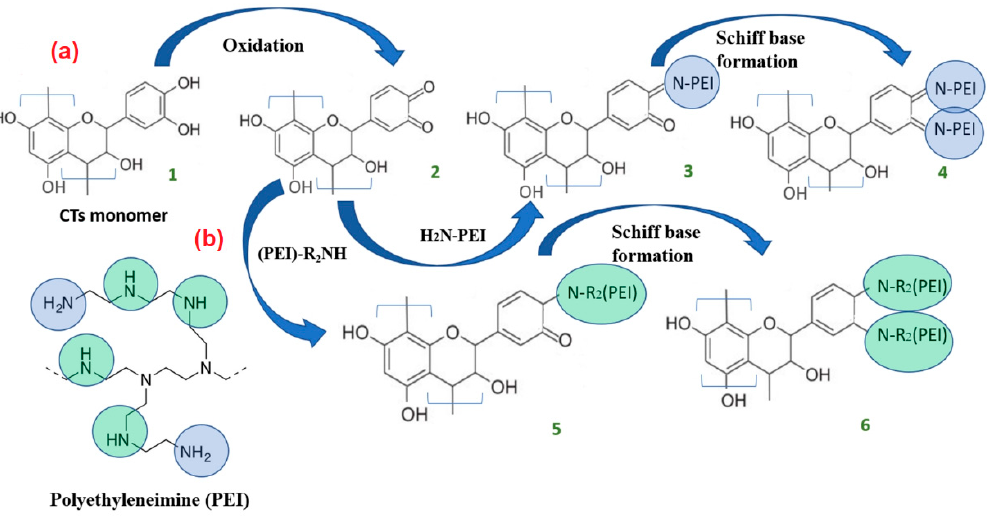
Figure 7. The possible schemes of the reaction between CTs and primary ( a ) and secondary amine ( b ) groups of PEI.